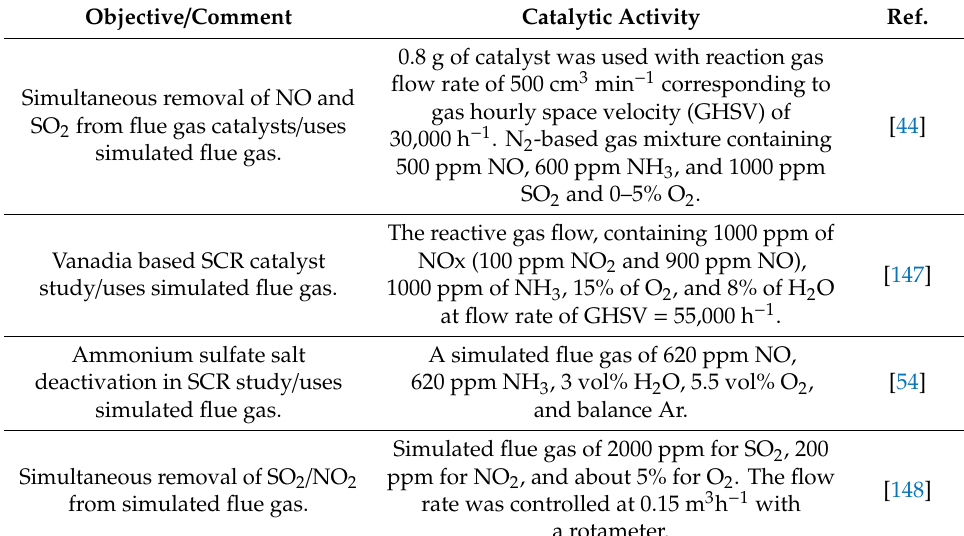
Table 5. Previous works on simultaneous SO 2 / NOx